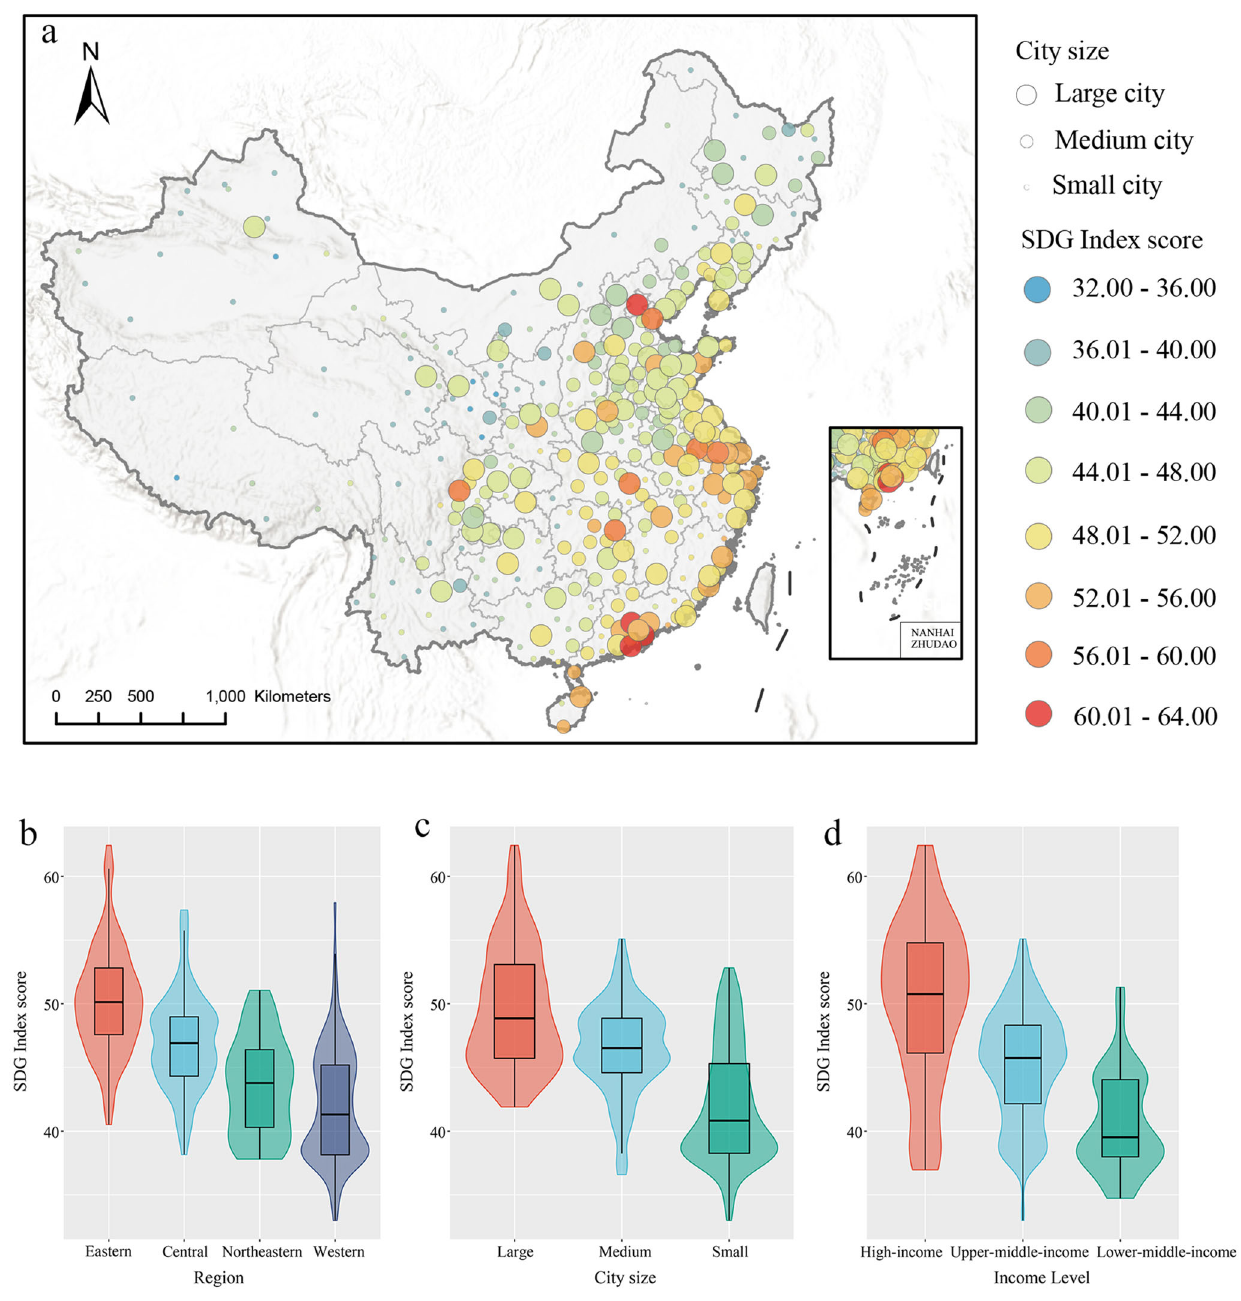
Fig. 4 Comparison of SDG Index scores for different city groups. a Spatial visualisation of the SDG Index scores of 337 cities. b Cities in different regions. c Cities of different sizes. d Cities with different income levels. For the classi fi cation standard, see Tables S2-4. The violin plots show the distribution, minimum, maximum, and median SDG Index scores for different city groups. The box plots show the maximum, fi rst quartile (Q1), median, third quartile (Q3), and minimum levels of the SDG Index scores for the different city groups. The base map in Fig. 4a was downloaded from the Resource and Environment Science and Data Center (https://www.resdc.cn/Datalist1.aspx?FieldTyepID = 20,0). The background map of Fig. 4a is the online basemap (World Hillshade) of ArcGIS Pro software from Esri (https://www.arcgis.com/home/item.html?id =